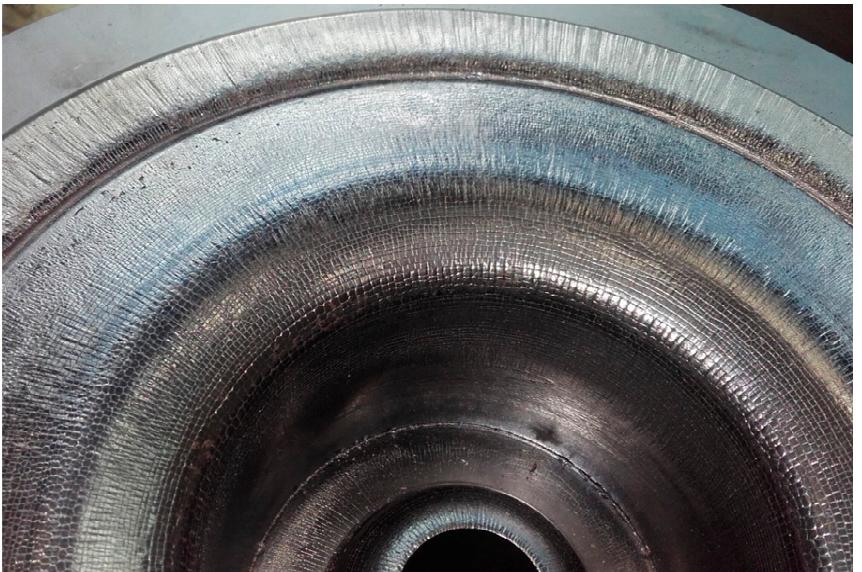
Figure 12. Forging die of forge 2 after